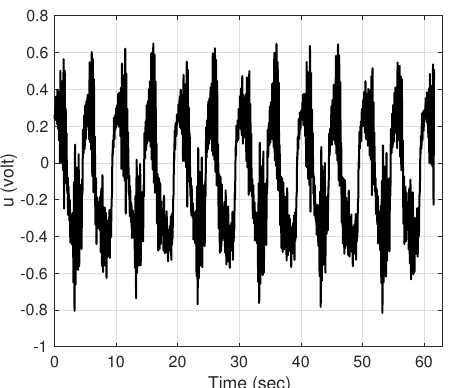
Figure 8. Experimental control effort of the closed-loop system.